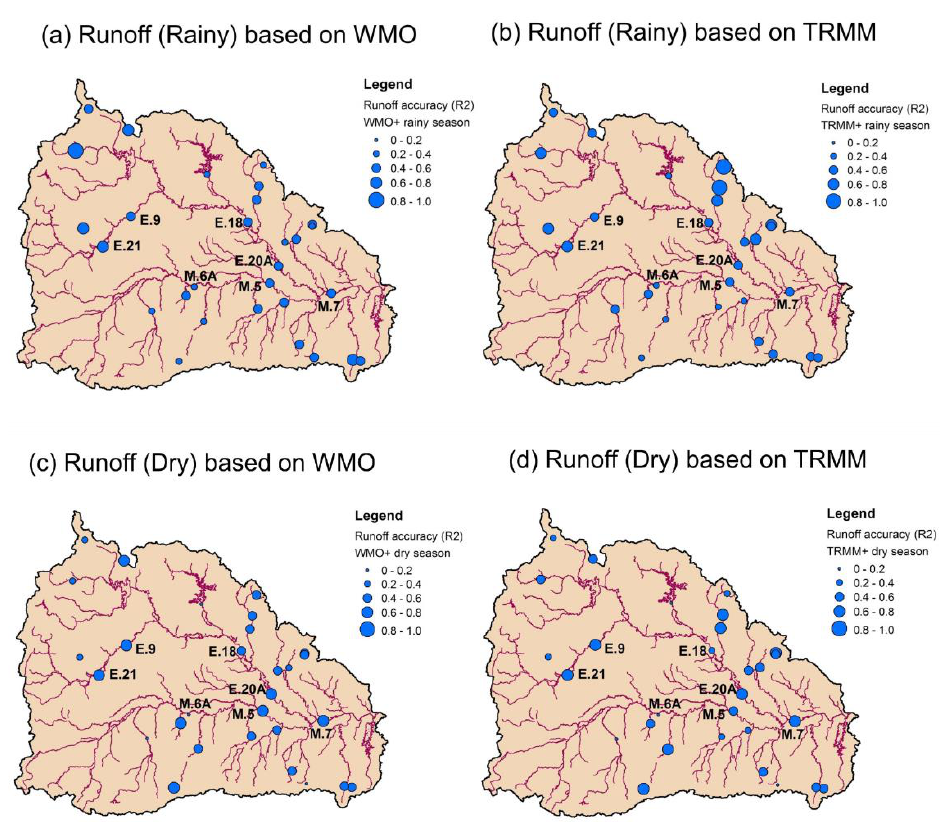
Figure 4. The correlation map of runoff simulation based on ( a ) WMO during rainy season; ( b ) TRMM during rainy season; ( c ) WMO during dry season; ( d ) TRMM during dry season from 2003 to 2008.